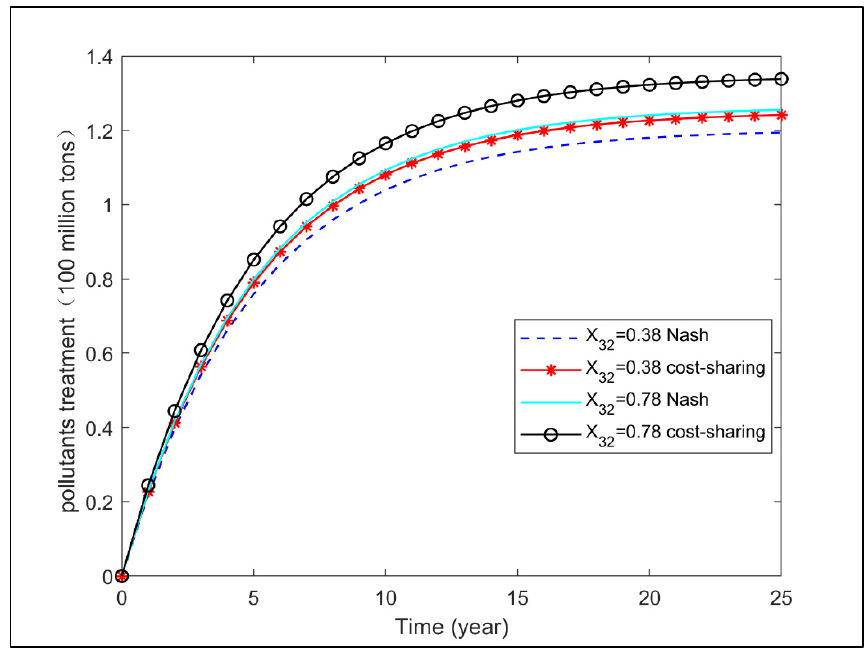
Figure 9. The effects of Shaanxi province’s X 32 on pollutants treated.